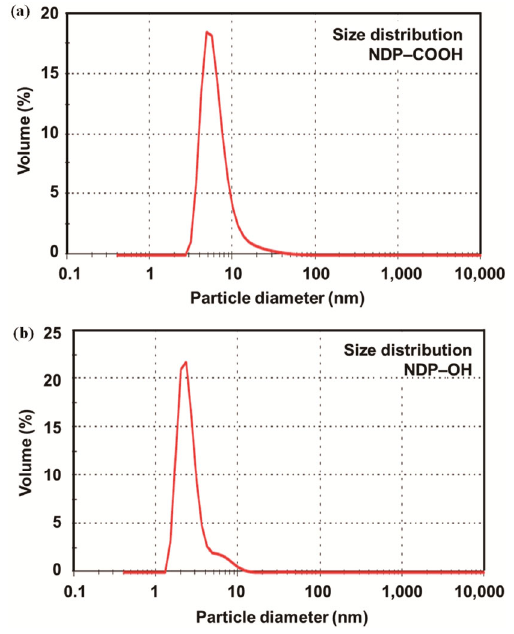
Fig. 2 Size distributions of (a) NDP–COOH and (b) NDP– OH. COOH and ND–OH are 5.8 and 2.4 nm, respectively. These two NDPs are then dispersed separately in water to form two stock solutions. Arbitrary